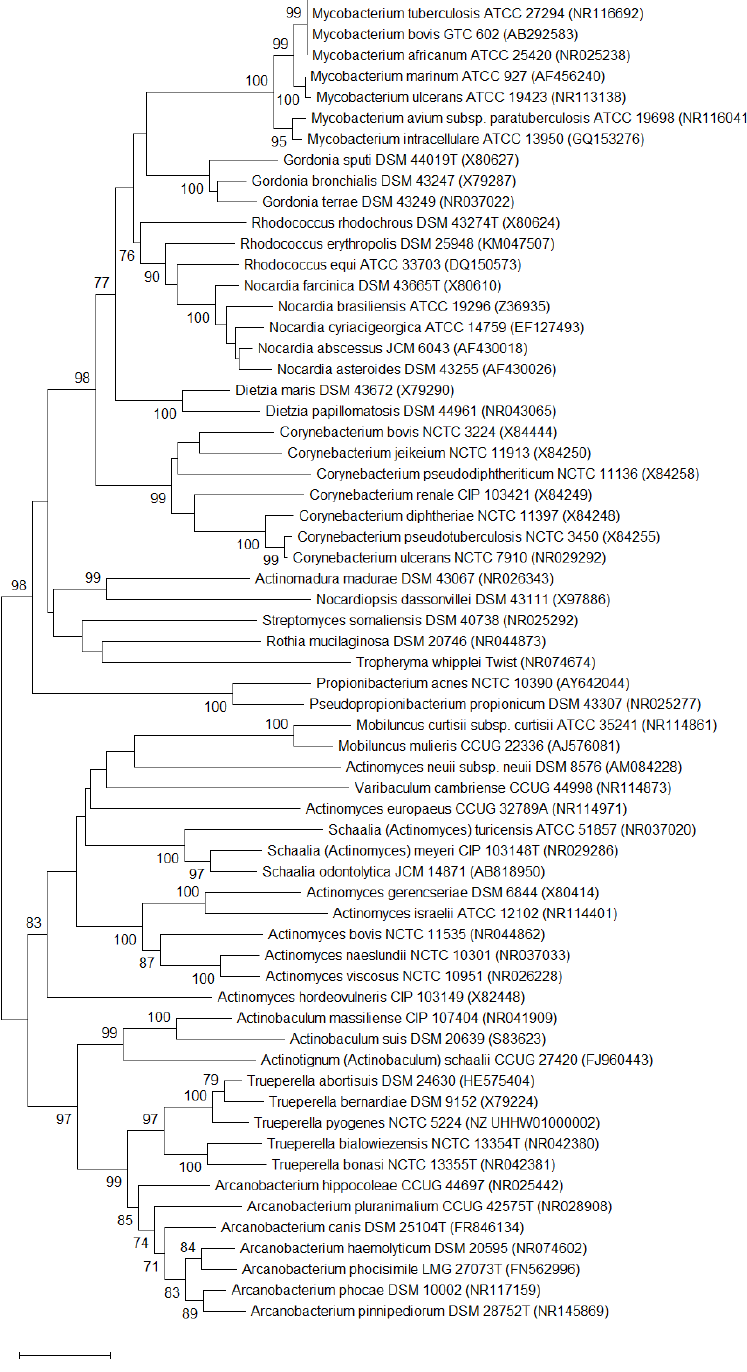
Figure 1. Neighbor-joining [15,16] phylogenetic tree based on 16S rRNA gene sequences (a total of 1422 positions in the final dataset) of Trueperella pyogenes , other Trueperella species, and related taxa. Only bootstrap values of 70%, based on 1000 replicates, are shown next to the branches [17]. The scale bar represents the number of substitutions per site. The analysis involved 64 nucleotide sequences derived from the GenBank ® database, and the evolutionary relationships were calculated in MEGA X